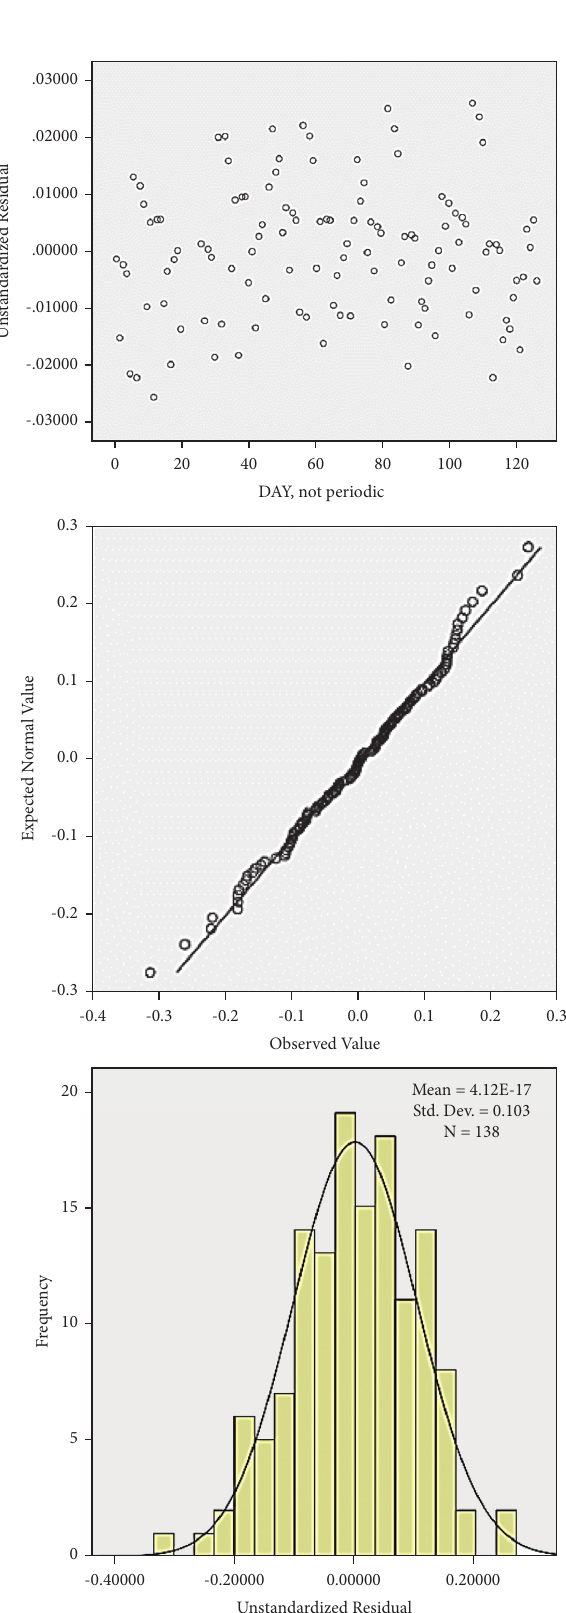
Figure 10: Histogram, quadratic diagram, and variance diagram of lateral friction coefficient